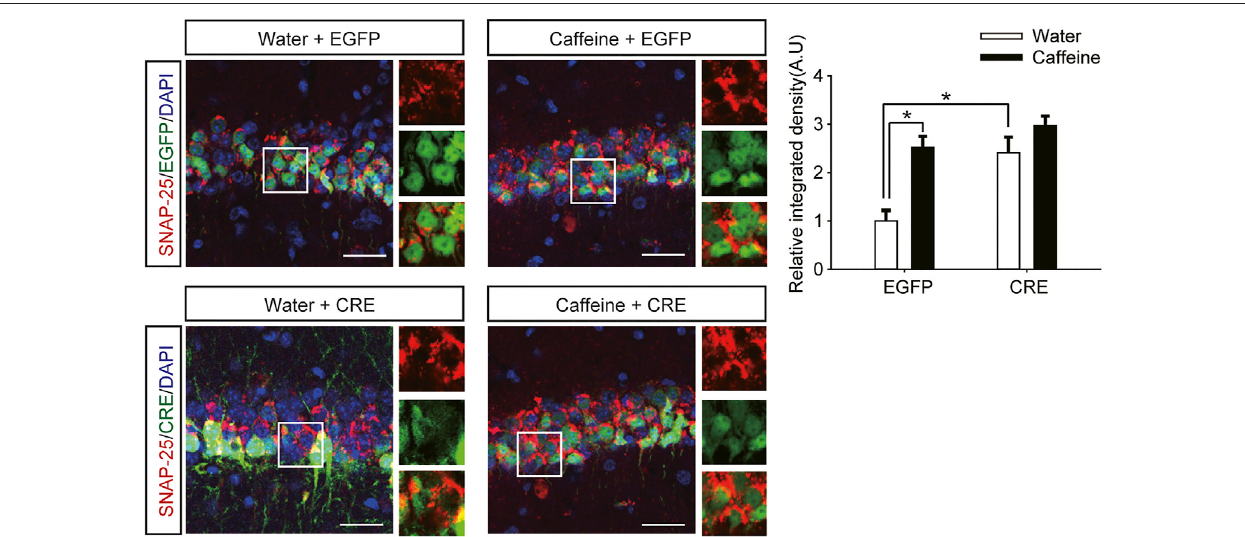
FIGURE 3 | Selective deletion of dHPC A 2A Rs improves SNAP-25 expression. Caffeine promoted SNAP-25 expression more in mice with the dHPC transfected with pAAV-EGFP than in mice transfected with pAAV-CRE. pAAV-CRE transfection also produced an additive effect on SNAP-25 levels independently. Representative images(left)and data(right)arepresented asthemean±SEM; n =27 fi eldspergroup (3 fi eldspersection, three sectionsper mouse, threemice pergroup). Scalebar = 30 μ m.